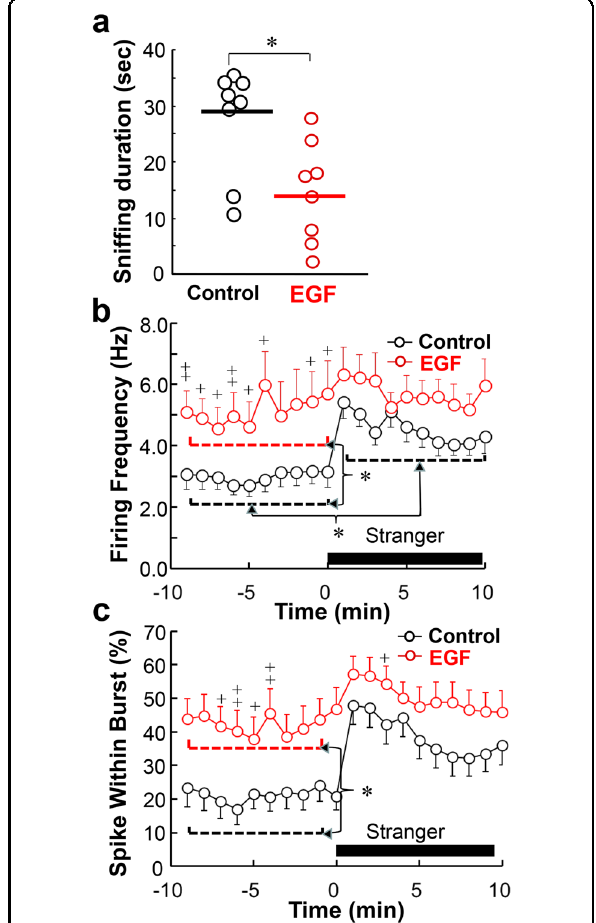
Fig. 2 Spiking activities of putative dopaminergic neurons in the ventral tegmental area during social interaction tests. a Social interaction scores in epidermal growth factor (EGF) model rats ( n = 8) and control rats ( n = 8) were assessed by same-gender af fi liative snif fi ng under mild aversive conditions (see details in the “ Materials and methods ” section) and compared by Mann – Whitney U test. b In vivo extracellular single ‐ unit recording in the VTA of freely moving rats with the aid of a wireless system. Putative dopaminergic cell fi ring was isolated from control rats (20 cells/12 rats and EGF model rats (17 cells/13 rats) and monitored during the social interaction with an unfamiliar male rat (Stranger). Averaged overall frequency of each rat group before and after social stimulation was calculated to estimate the main effects and then compared by Mann – Whitney U test with the Holm ’ s compensation; * P < 0.05. In addition, the mean fi ring frequency during each 1 min time bin was compared between rat groups by Mann – Whitney U test without the Holm ’ s compensation; + P < 0.05, ++ P < 0.01. c Mean spike within bursts (SWB, %) was calculated from the same single ‐ unit recording. Averaged overall SWB of each rat group before and after social stimulation was similarly calculated and compared to each other by two-way ANOVA followed by Tukey post hoc test. In addition, mean SWB at each time bin was compared between rat groups by Mann – Whitney U test without the Holm ’ s compensation; + P < 0.05, ++ P <